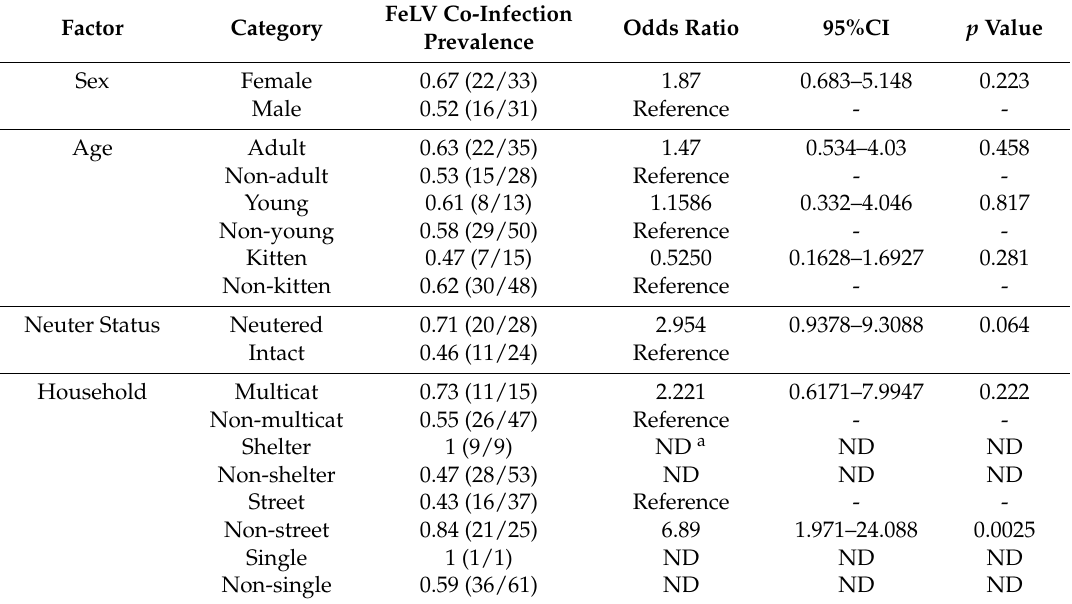
Table 5. Univariate analysis of the prevalence and risk factors for FeLV and FFV co-infection in domestic